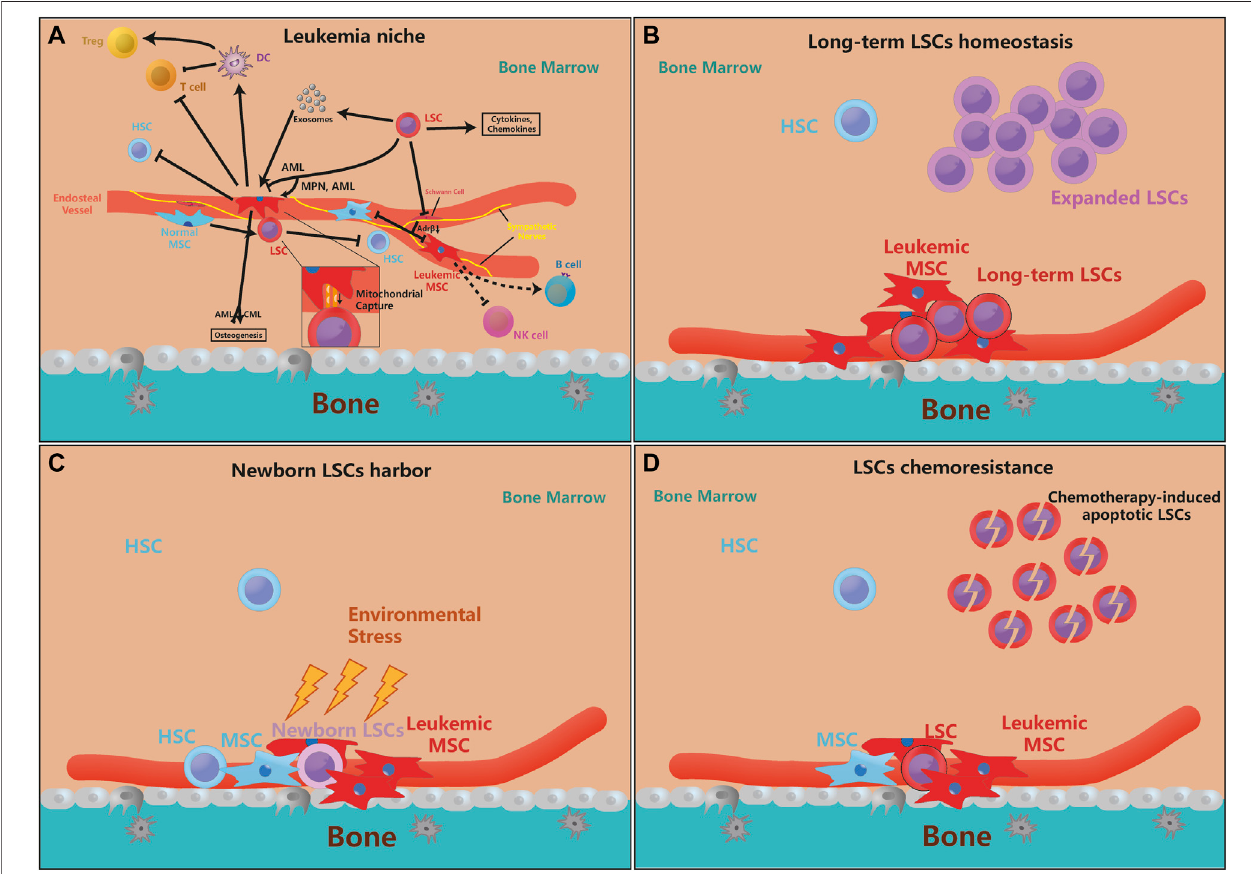
FIGURE 1 | MSCs are essential for leukemia initiation and progression. (A) . The pathological LSCs drive MSCs to leukemic-permissible MSCs through physical interactions, cytokines, chemokines, and exosomal secretion, and regulation of their osteogenesis ability. Moreover, leukemic MSCs inhibit the stemness and self- renewal of normal HSCs, but physiological MSCs also promote the proliferation and anti-apoptosis ability of LSCs for their bene fi ts. On the other hand, LSCs can also denervate SNS and inhibit the release of Adr β , making their inhibition of MSCs ineffective. Furthermore, leukemic MSC can directly or indirectly inhibit T cell activity and proliferate Tregs, but its function on B cells, etc. is not yet clear. Besides, more evidence reveals that genetically mutated MSCs are enough to motivate HSCs leukemogenesis(thearrowmeansthatthesourcecellpromotestheproliferationorfunctionoftargetcell,andtheinhibitorysymbolmeansthatthesourcecellinhibitsthe proliferation or function of target cell). (B – D) . The supporting effect of MSCs on LSCs is mainly in three aspects, which is the maintenance of quiescent LSCs, the protection of newborn LSCs, and LSCs chemoresistance. Some newly mutated LSCs need the protection of MSCs to avoid environmental stress and evade immune surveillance. MSCs can also protect a part of quiescent LSCs to maintain the ability for long-term leukemogenesis, while the expansion of LSCs does not depend on MSCs very much. When chemotherapy kills LSCs, MSCs can help LSCs chemoresistance and promote recurrence.